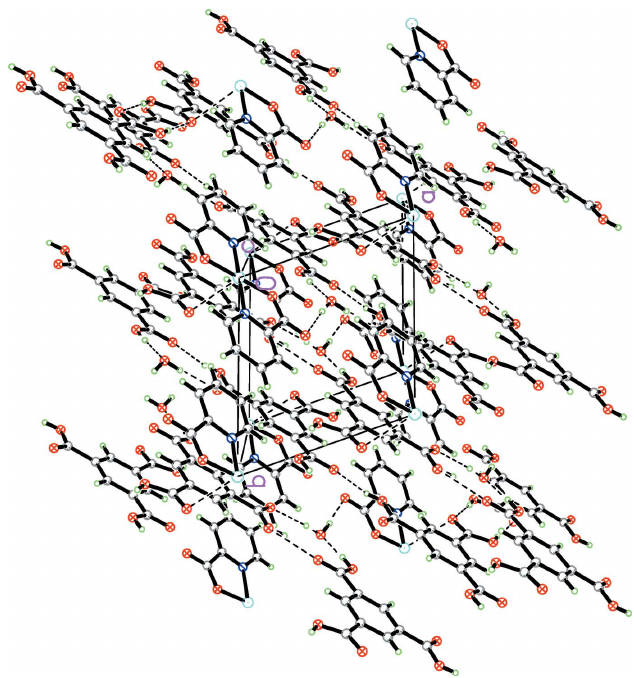
Figure 2 The packing of the title compound. Hydrogen bonds and Cu (cid:2)(cid:2)(cid:2) O interactions are shown as dashed